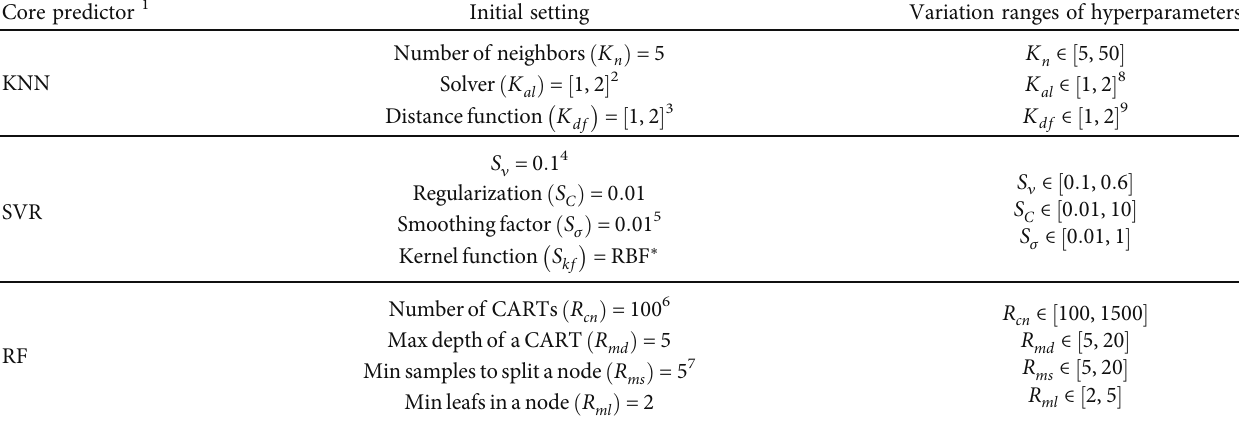
Table 5: Initial settings of competitive predictors and variation ranges of applied hyperparameters. Core predictor